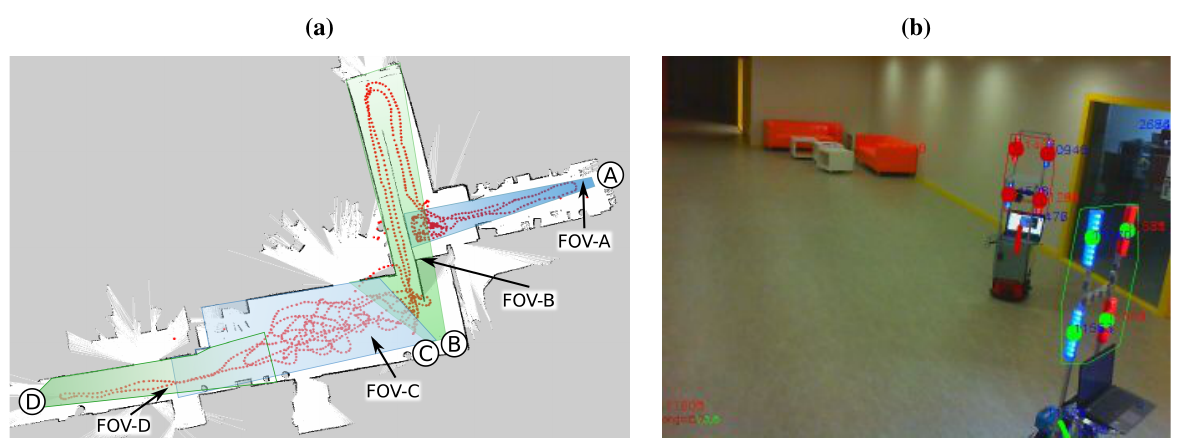
Figure 15. Deployment of our self-organised multi-agent network with two robots working in the environment. ( a ) FOV of each camera, and trajectory of one of the robots. ( b ) Snapshot of both robots taken from camera C.